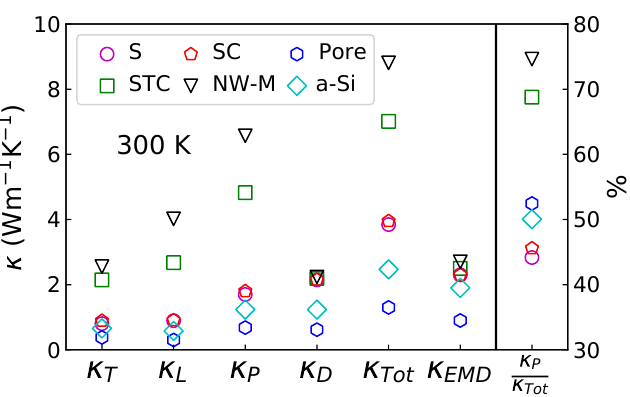
Figure 6. Thermal conductivities at 300 K, decomposed through Equations (3) and (4) and computed with EMD. The proportional contribution to the thermal conductivity of the propagative mode is also represented in the right part of the figure (right